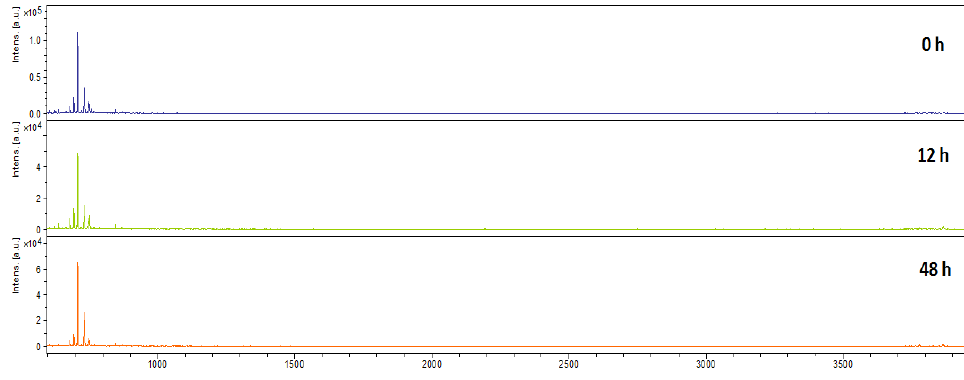
Figure 3. Comparison of the peptide fractions of Lens culinaris material through the analysis of se- lected MALDI TOF spectra with the RP method.